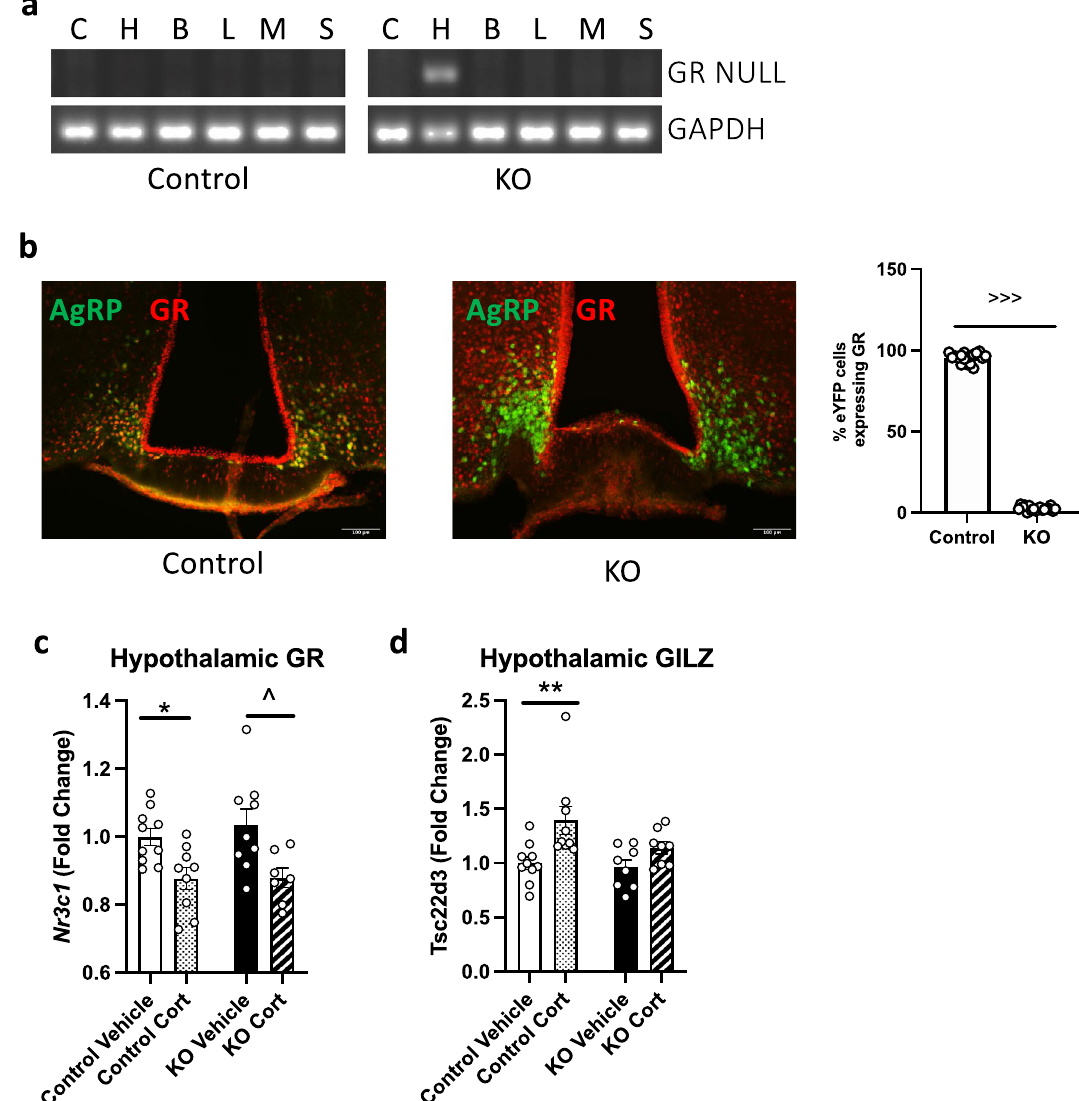
Figure 1. GR is knocked down in AgRP neurons. ( a ) Recombination of the NULL band is only present in the hypothalamus of male AgRP-GR KO mice. ( b ) Representative image showing co-localisation of GR and eYFP (AgRP) in the arcuate nucleus of female control, but not female AgRP-GR KO mice. Graphical insert showing the percentage co-localisation of GR and AgRP. ( c ) Nr3c1 (GR) and ( d ) Tsc22d3 (GILZ) mRNA expression in the whole hypothalamus of vehicle and 3 week Cort treated female control and AgRP-GR KO mice. C: cerebellum, H: hypothalamus, B: brown adipose tissue, L: liver, M: skeletal muscle, S: subcutaneous adipose tissue. ( a ) n = 1, ( b ) n = 4, graphical representation of 18 sections per genotype, unpaired student’s t -test ( c ) and ( d ) n = 7–10, Mann–Whitney non-parametric t-tests. * P < 0.01, ** P < 0.01 control vehicle versus Cort. ^ P < 0.05 KO vehicle versus KO Cort. >>> P < 0.001 control versus